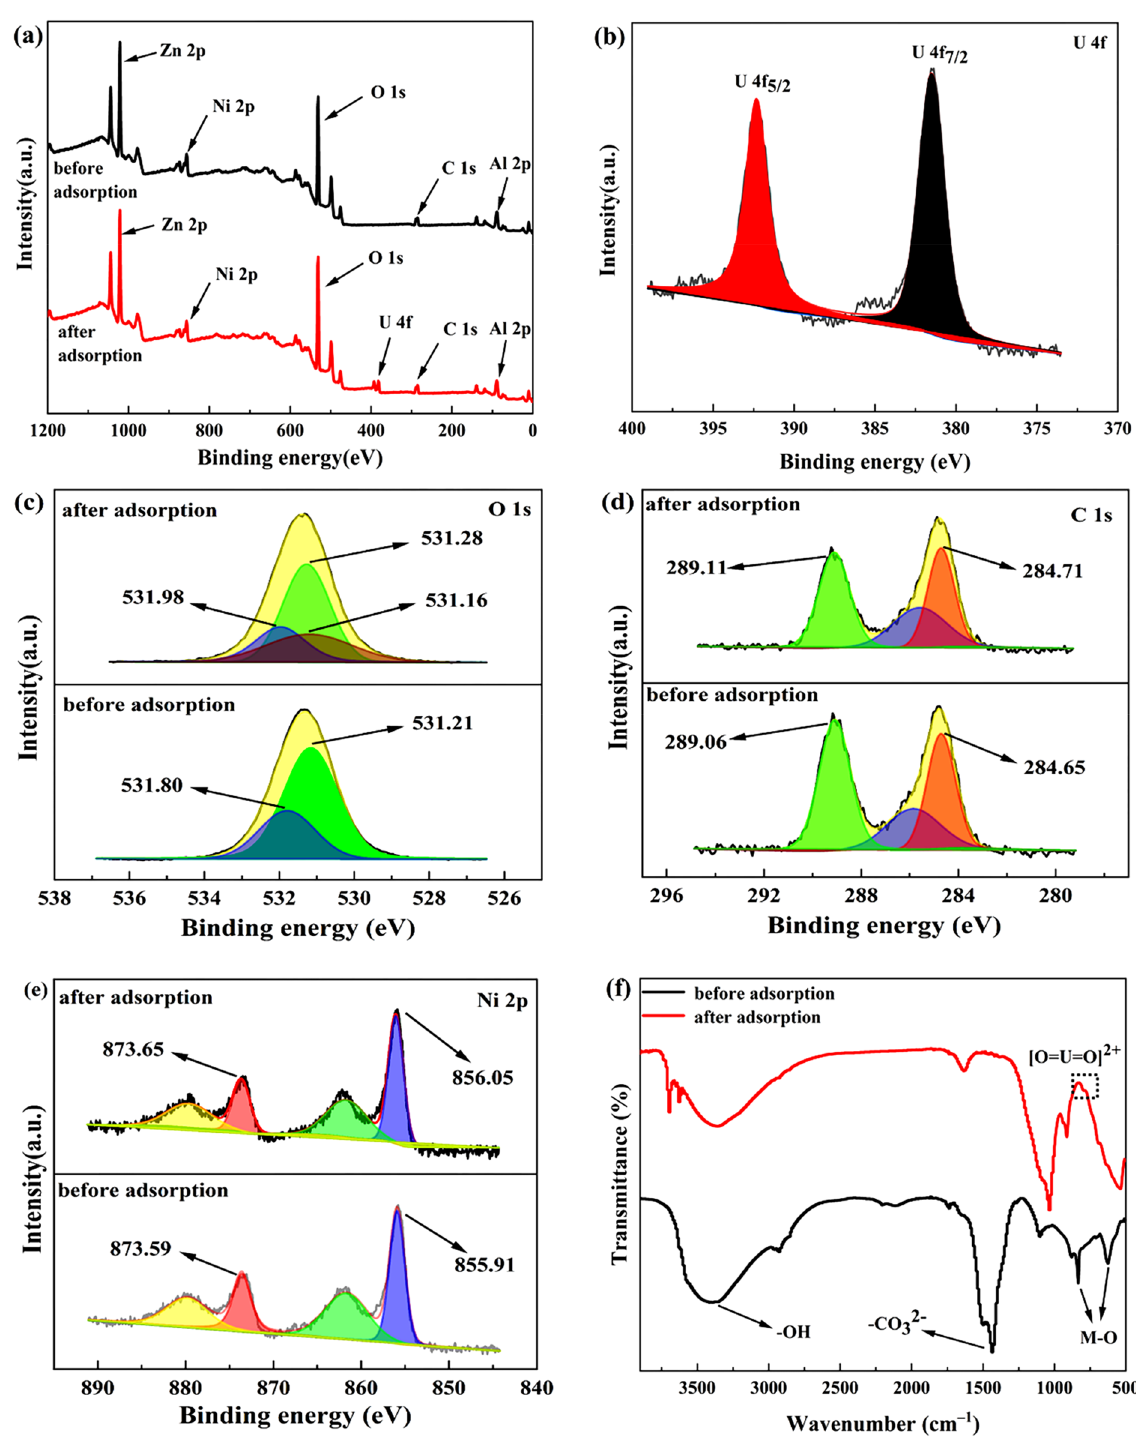
Figure 10. Wide scan XPS spectra ( a ), high-resolution XPS spectra of U 4f ( b ), O 1s ( c ), C 1s ( d ), Ni 2p ( e ) and FT-IR spectra ( f ) of ZnNiAl-LDHs before and after adsorption of